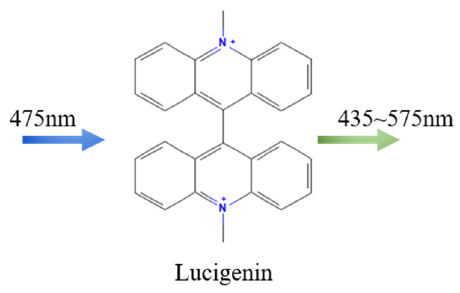
Figure 5. Schematic illustration of the photoluminescence strategy for detecting lucigenin activity.